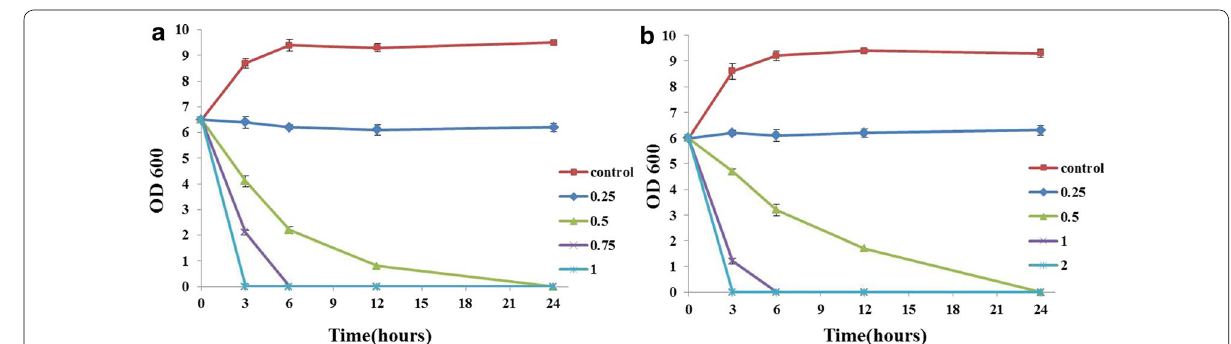
Fig. 6 Time-kill assay of active component from GN59 against E. coli ( a ) and S. aureus ( b ). The X axis indicates time in hours after various concentrations of the trehalosamine as indicated (mg/mL) were added into E. coli ( a ) and S. aureus ( b ) cultures and the Y axis indicates the CFU/mL of E. coli ( a ) and S. aureus ( b ) after